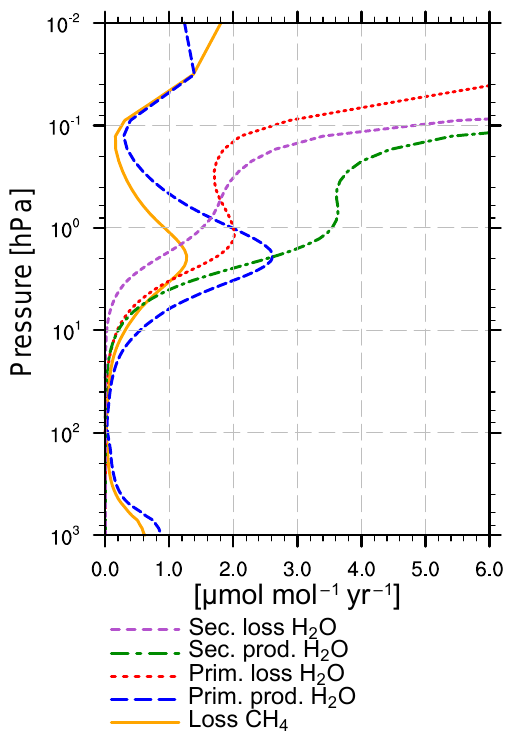
Figure 11. Separate loss of CH 4 and primary and secondary loss and production of H 2 O from the global simulation (23 ◦ S–23 ◦